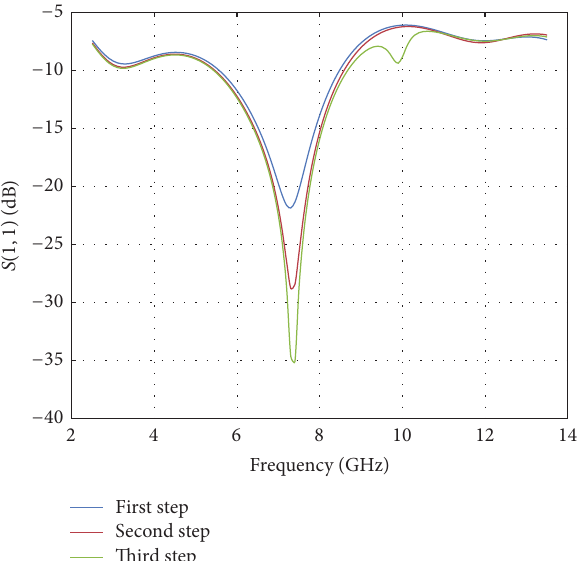
Figure 6: Antenna input reflection coefficient versus frequency. The curves refer to the first three steps’ design.